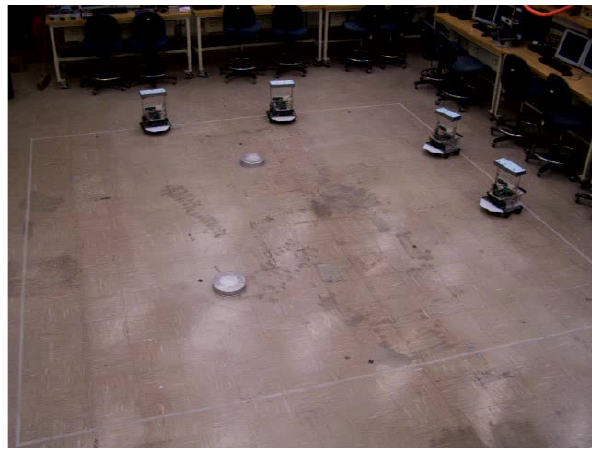
Fig. 8. Multi-robot experimental testbed.